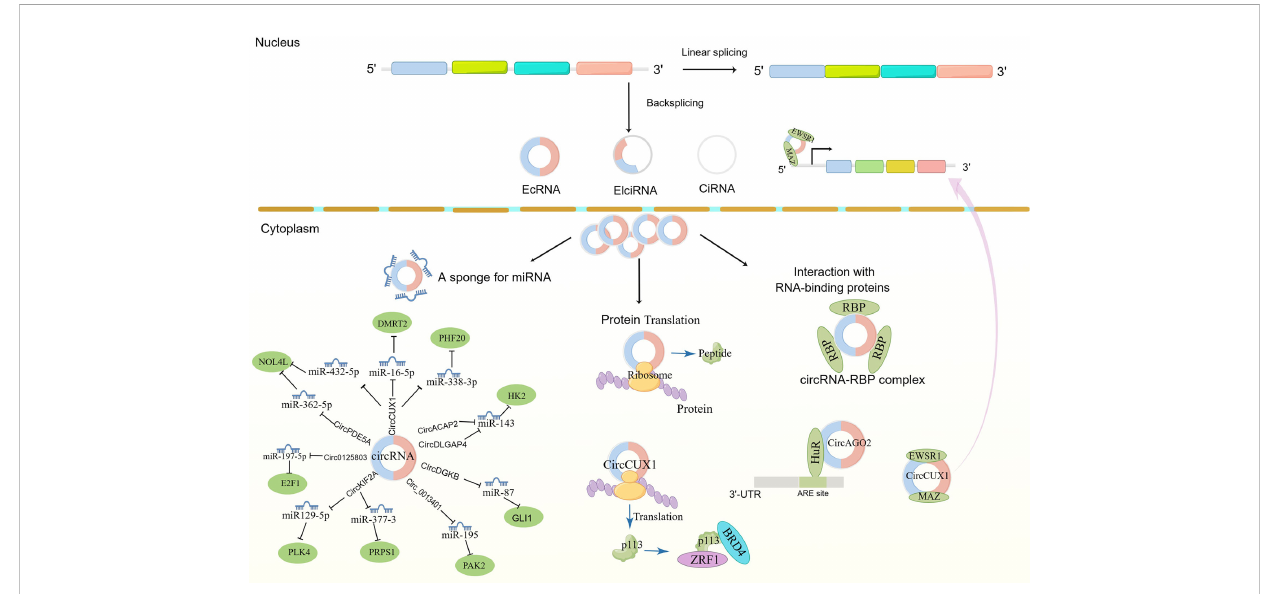
FIGURE 1 The biogenesis of circRNAs and mechanism in neuroblastoma cancer cell progression. EcRNAs, Exonic circRNAs; EIciRNAs, Exonic-intronic circRNAs; CiRNAs, intronic circRNA. EWSR1,EWS RNA binding protein 1; MAZ, MYC-related zinc fi nger protein; DMRT2, Doublesex and mab-3 related transcription factor 2; NOL4L, Nucleolar protein 4 like; PHF20, PHD Finger Protein 20; Zuotin-related factor 1; BRD4, bromodomain protein 4; PLK4, Polo-like kinase 4; PRPS1, Phosphoribosyl pyrophosphate synthetase 1; GLI1, Glioma-associated oncogene 1; AGO2, Argonaute 2; HK2, hexokinase 2; PAK2, P21-activated kinase 2; HuR, Human antigen